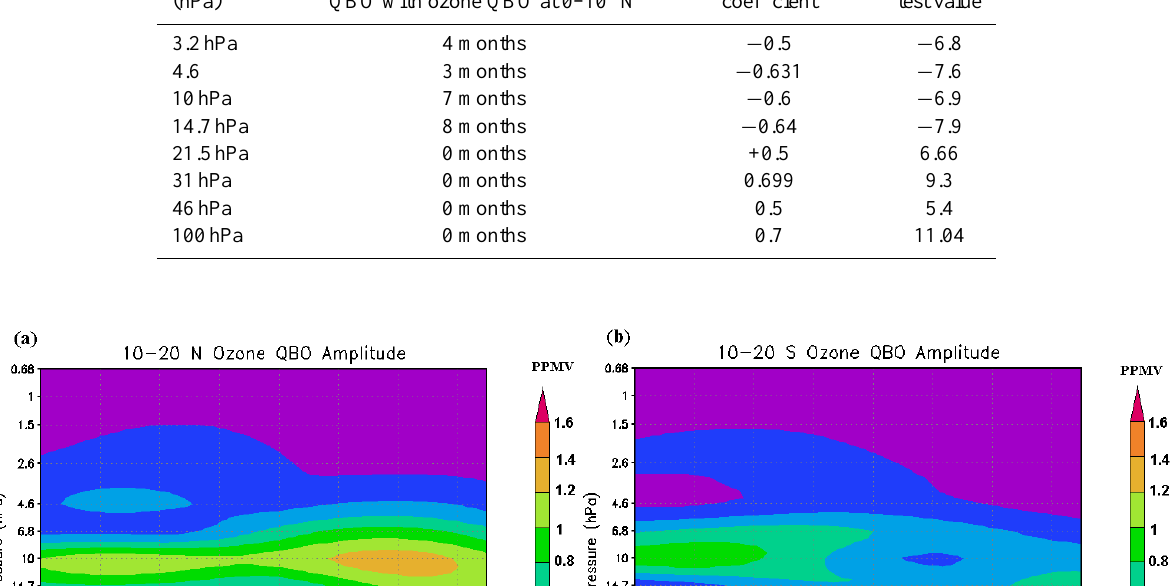
Table 2. Vertical variation of lag correlation of Singapore zonal wind QBO with ozone QBO over 0–10 ◦ N belt. Pressure level